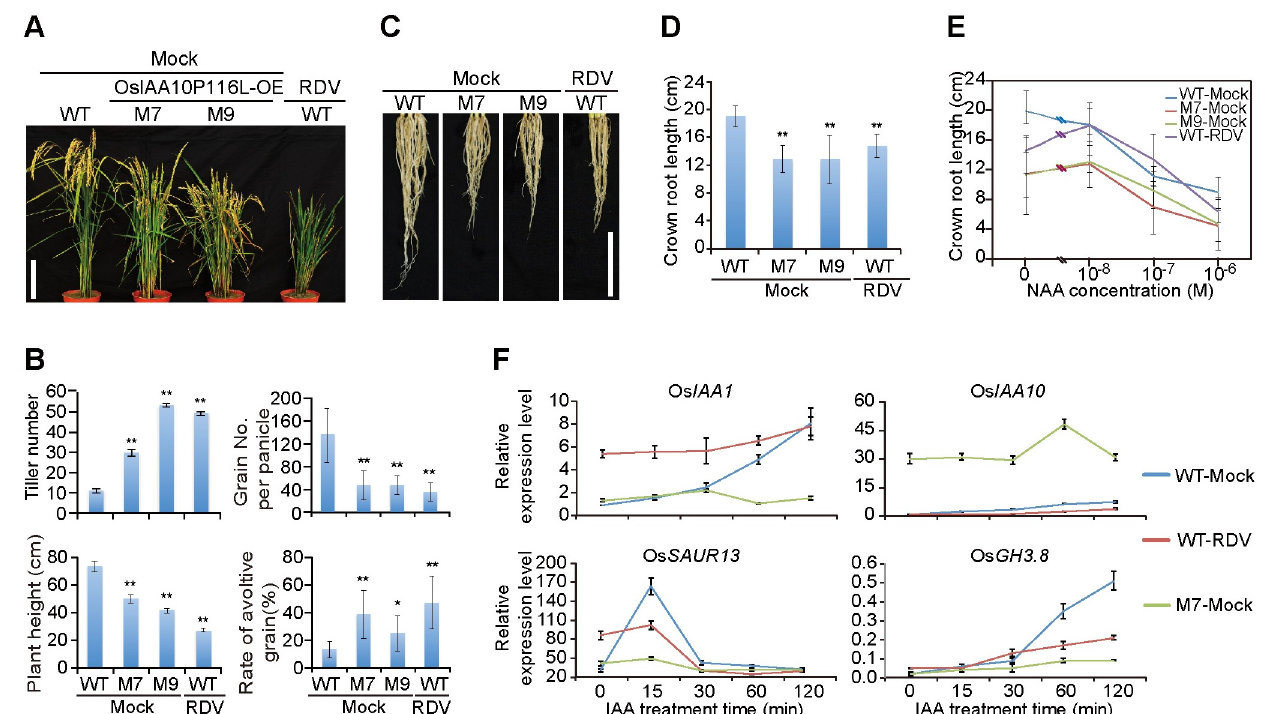
Fig 4. OsIAA10P116L-overexpressing transgenic rice plants phenocopy RDV-infected rice plants. (A) Morphologies of mock-inoculated M7 and M9 as well as WT-RDV plants at maturity stage. Bar: 15 cm. (B) Schematic representation of the tiller number, plant height, grain number per panicle, and rate of avoltive grain (%) for the above plants at maturity stage. The average ( ± SD) values were obtained from three biological repeats, with 15 plants from each line in every repeat. Significant differences were indicated ( * P < 0.05, ** P < 0.01) based on Student ’ s t -test. (C and D) Phenotypes (C) and schematic representation (D) of the length of the crown roots of 6-week-old mock-inoculated WT and OsIAA10P116L-overexpressing (M7 and M9), as well as RDV-infected WT, rice plants. Bar: 10 cm. The average ( ± SD) values were obtained from three biological repeats, with 15 plants from each line in every repeat. Significant differences were indicated ( ** P < 0.01) based on Student ’ s t -test. (E) Lengths of crown roots of 6-week-old mock-inoculated WT, M7 and M9 as well as RDV-infected WT rice seedlings cultured in a liquid nutrient containing the indicated concentration of NAA. The average ( ± SD) values were obtained from three biological repeats, with 15 plants from each line in every repeat. (F) qPCR analysis of auxin-induced gene expression after IAA treatment in mock-inoculated WT and M7 as well as RDV-infected WT rice seedlings. The expression levels were normalized using the signal from OsEF1a , and values are mean ± SD (n = 3 biological replicates).